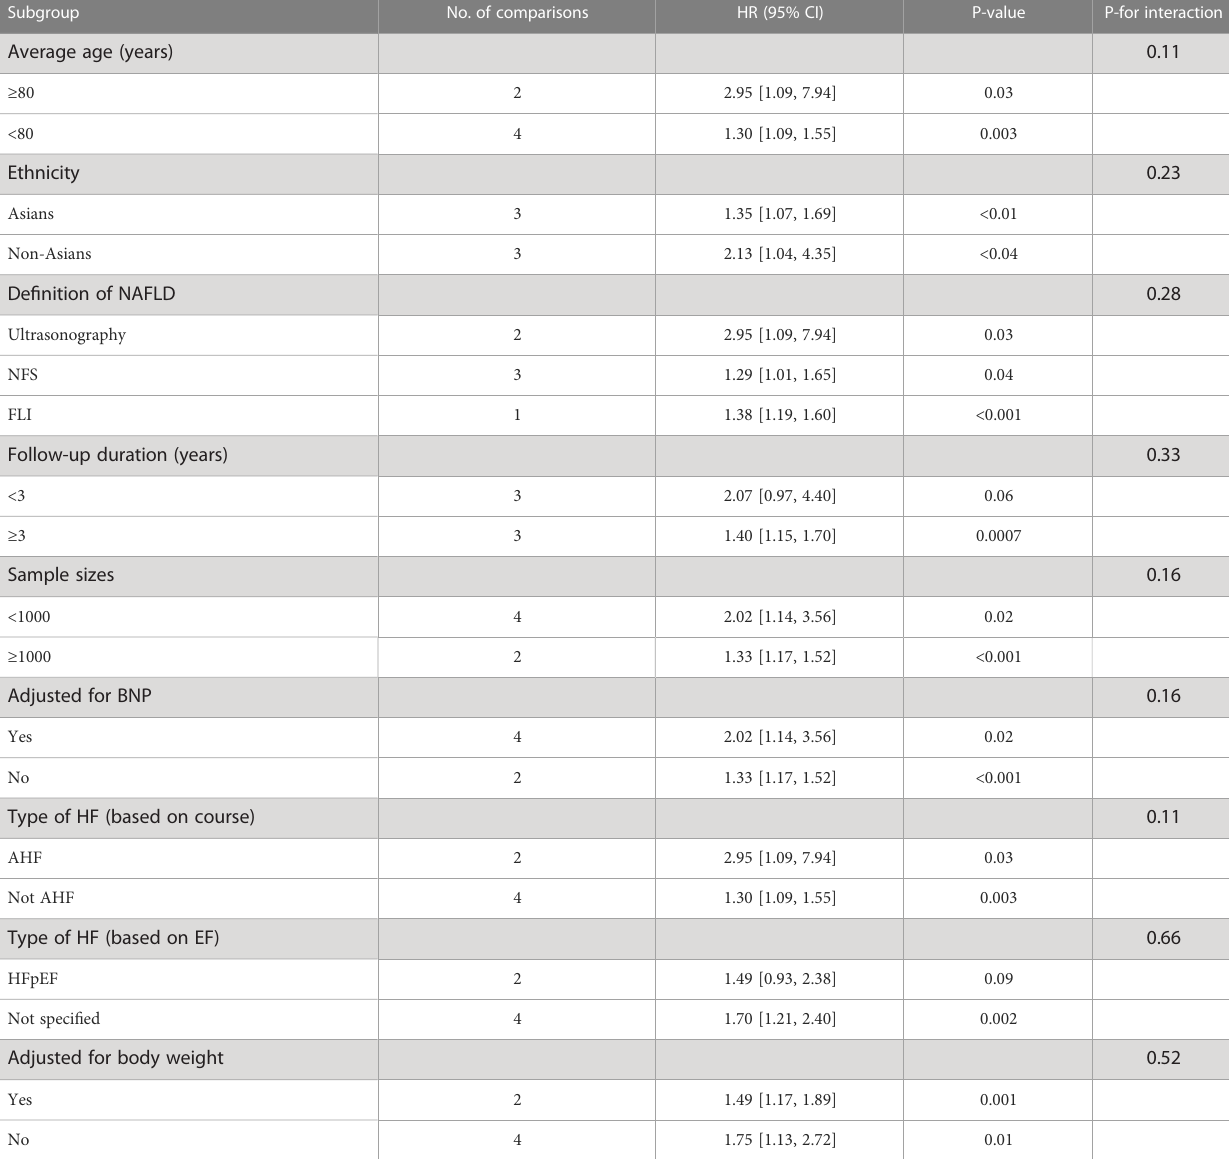
TABLE 2 Subgroup analyses of the association between NAFLD and primary adverse outcomes in patients with heart failure.